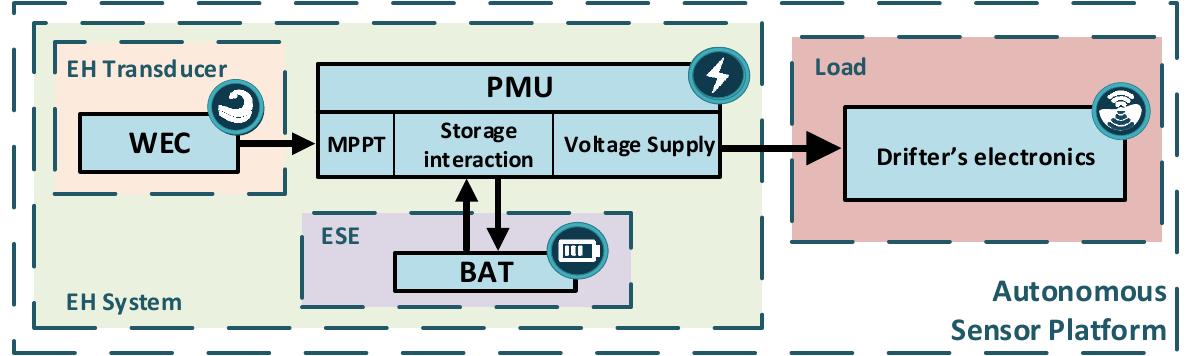
Figure 1. Autonomous Sensor Platform configuration; the load represents the drifter’s electronics, while the EH system includes the EH transducer (WEC), the PMU and the ESE.